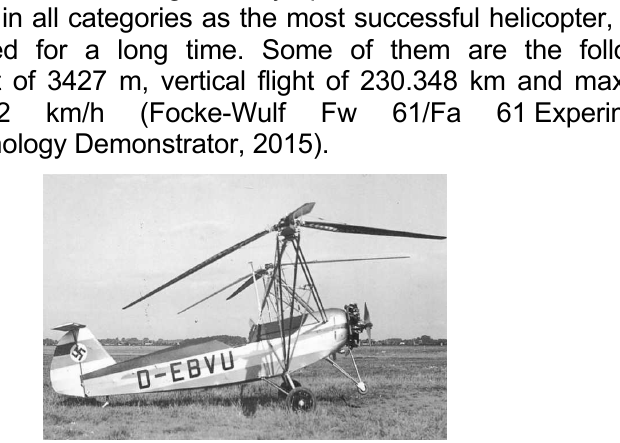
Figure 5 – The first flight of the Focke-Wulf Fw 61 (June 26, 1936) Рис . 5 – Первый полет Focke-Wulf Fw 61 (26 июня 1936 г .) Слика 5 – Први лет летелице Focke-Wulf Fw 61 (26. јун 1936. године )